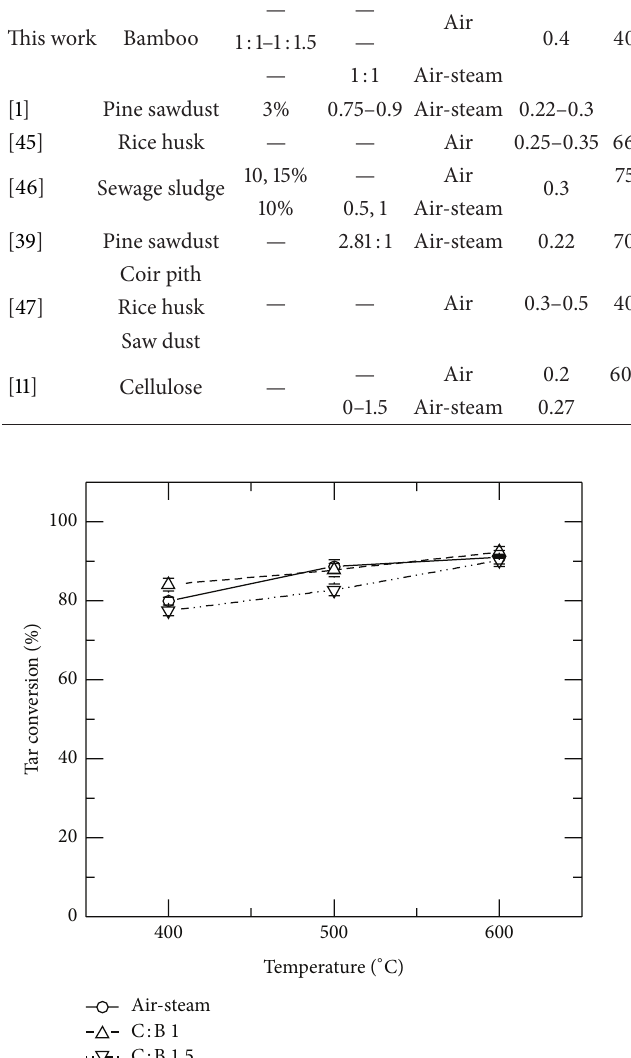
Figure 6: Effect of steam and catalyst ratio on tar conversion at different